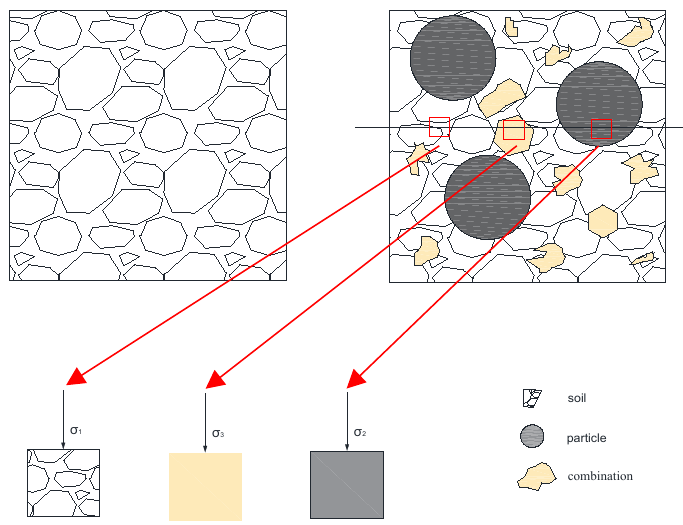
Figure 10. Schematic diagram of unit section’s principal stress after silt solidification.